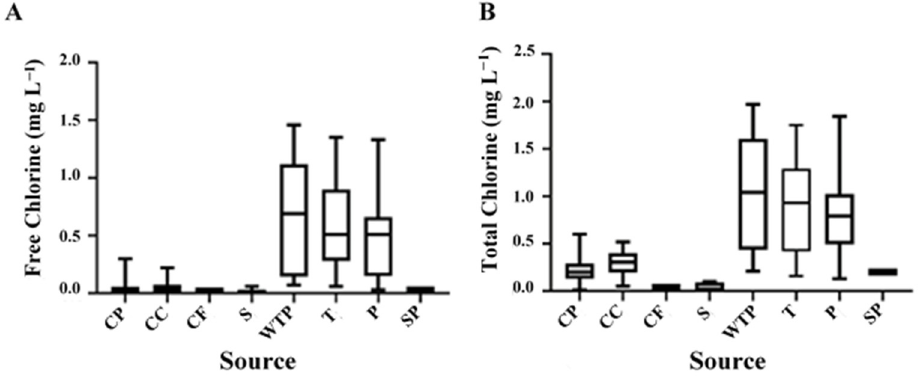
Figure 3. Concentration of free (panel A ) and total (panel B ) chlorine (mg L − 1 ) in each source of drinking water sampling point.